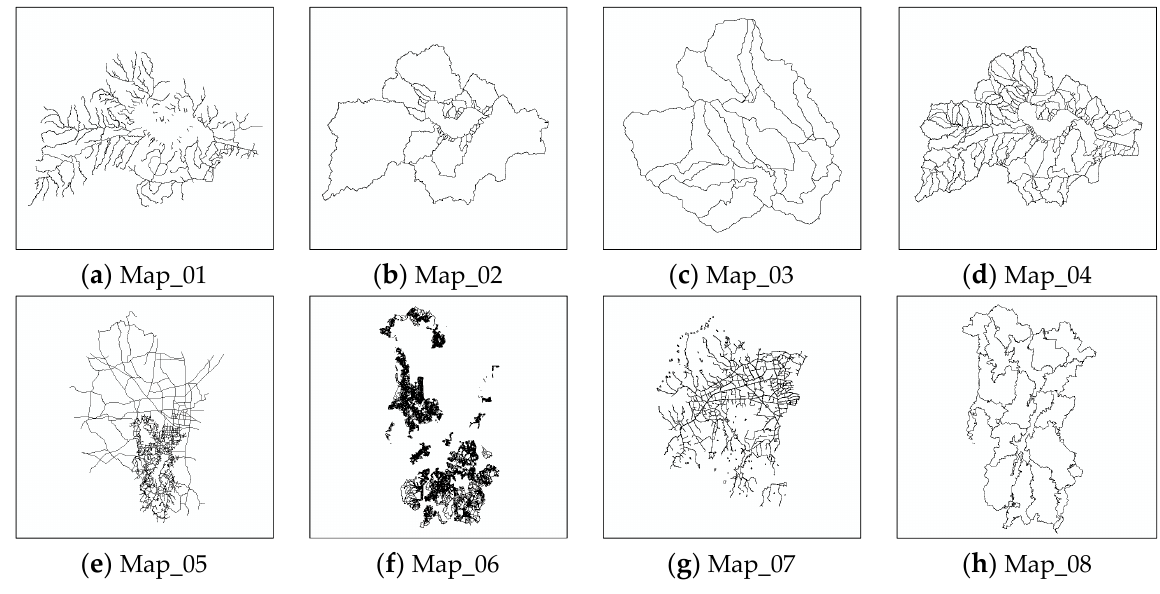
Figure 9. Eight of the fifty experimental vector maps. Table 4. Properties of the fifty adopted experimental vector maps.